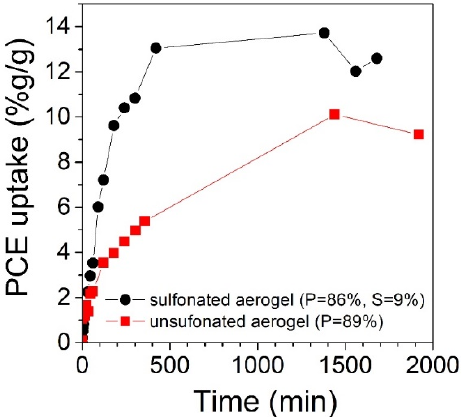
Figure 8. PCE uptake from a 10 ppm aqueous solution for an unsulfonated PPO aerogel (P = 89%) and for a sulfonated PPO aerogel (P = 86%, S = 9%).